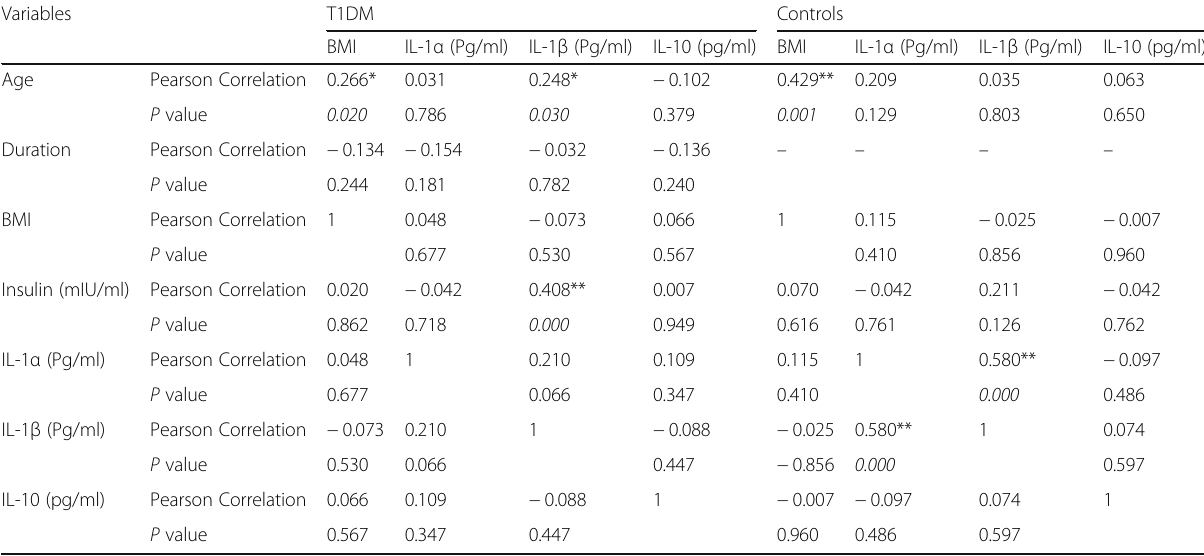
Table 3 Correlation between inflammatory cytokines and clinical and biochemical variables in T1DM patients and controls Variables